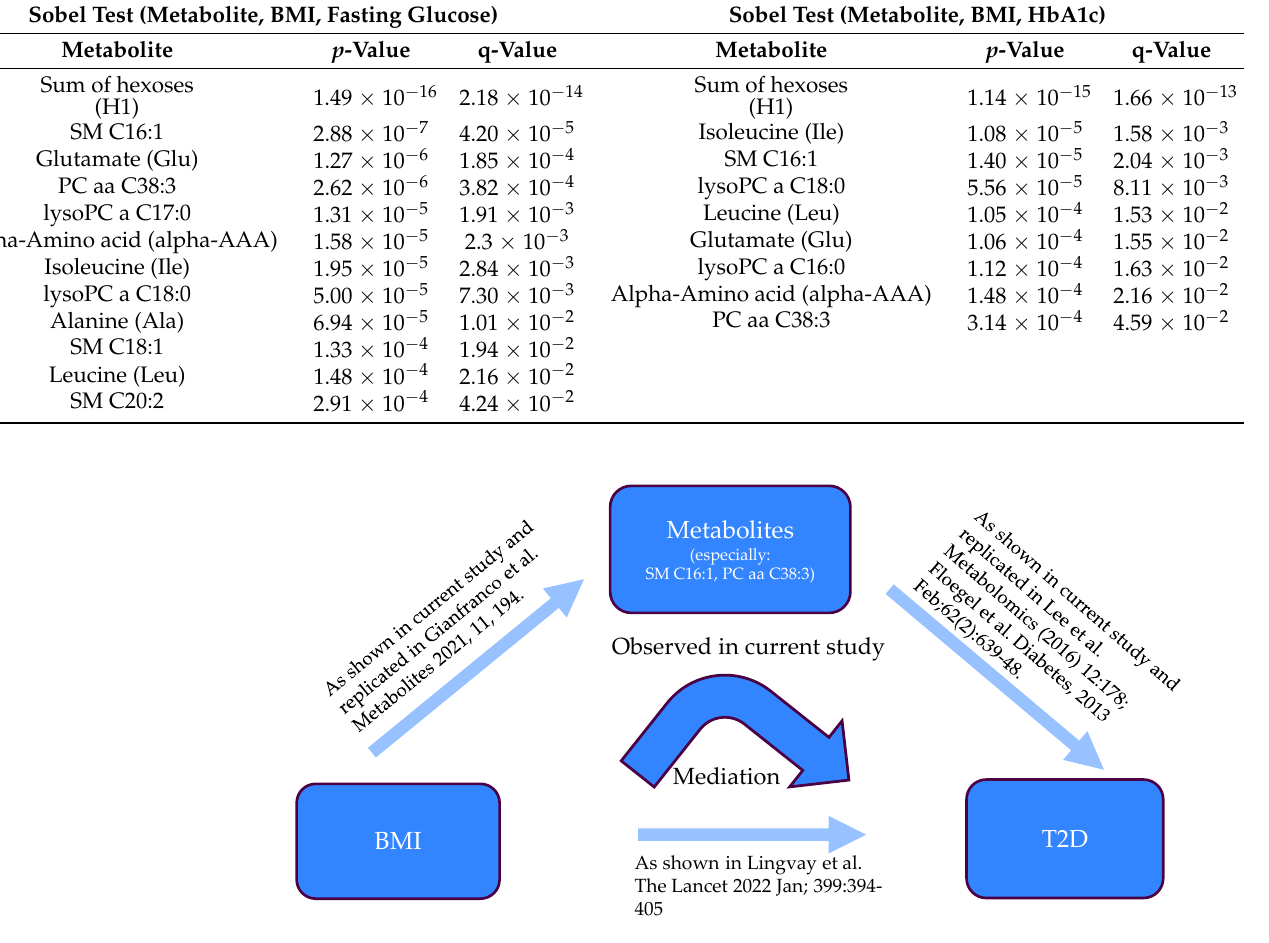
Figure 5. Schematic representation of the mediation analysis